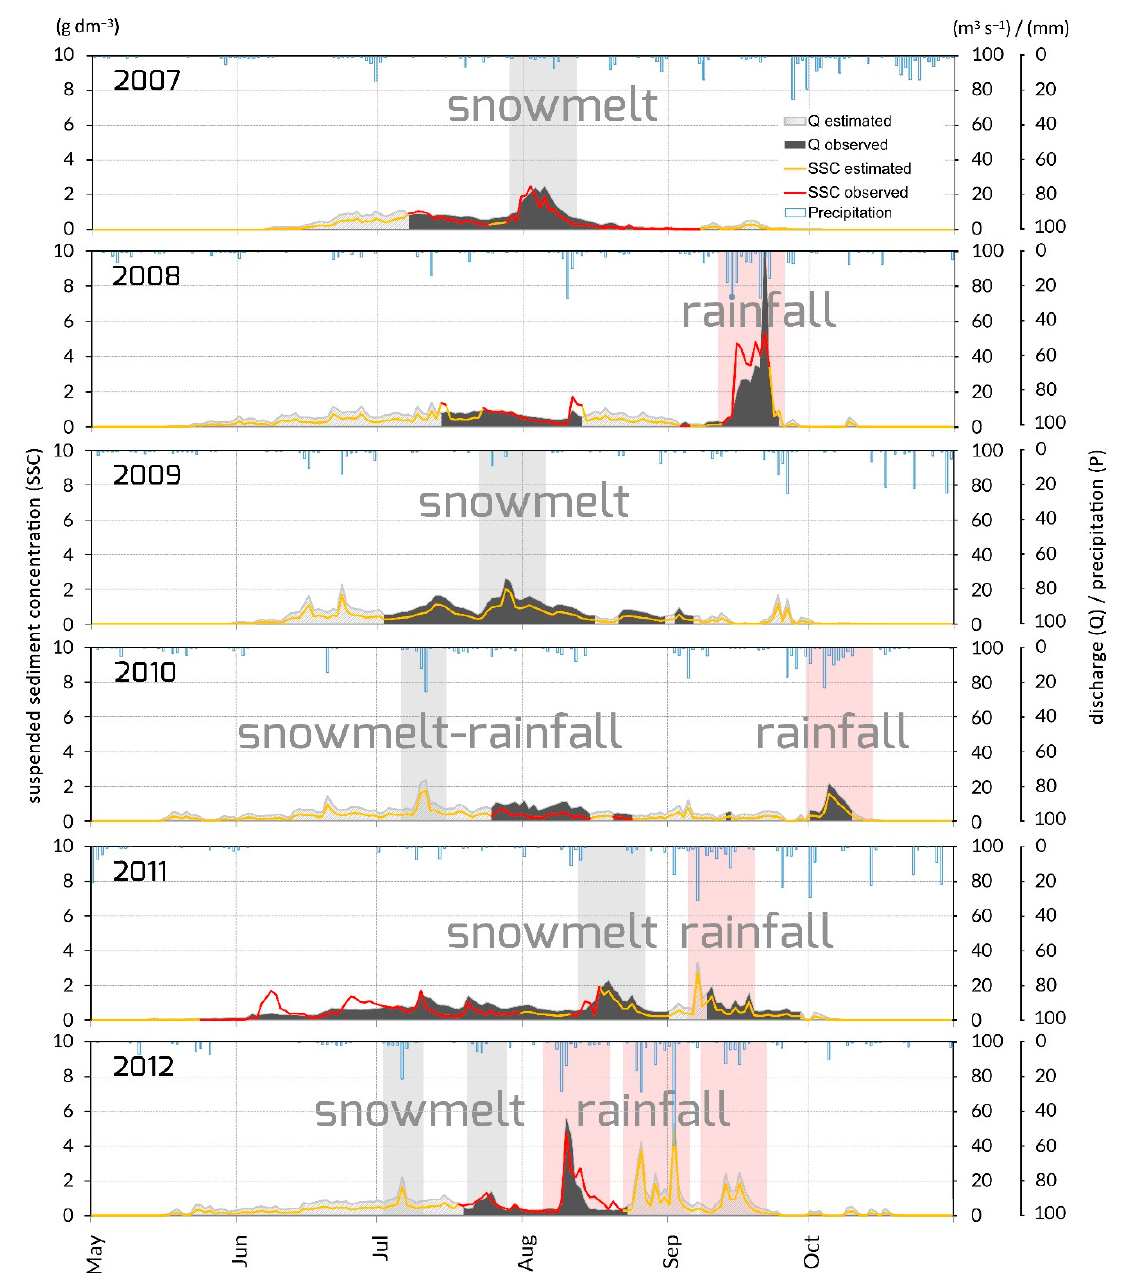
Figure 8. Discharge (Q) and suspended sediment concentration (SSC) in the Breelva River, with an indication of the origin of the peaks (shaded areas), with the background data of precipitation in Hornsund (P) [43].